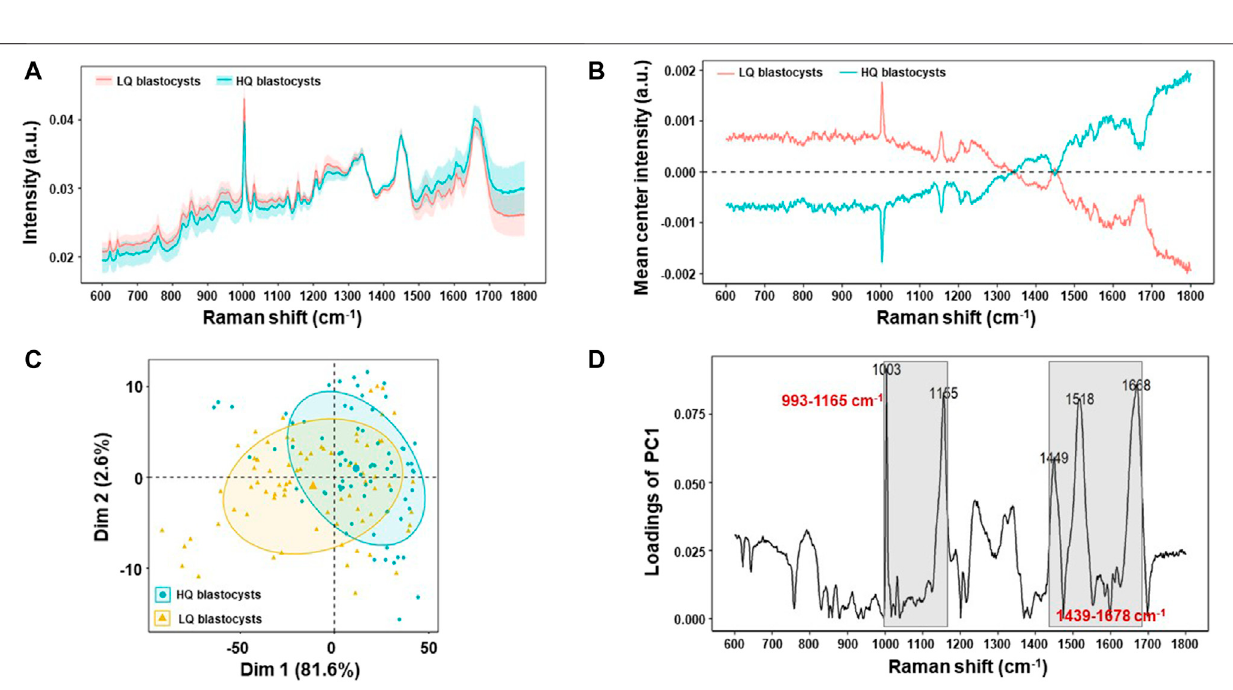
Frontiers in Cell and Developmental Biology |